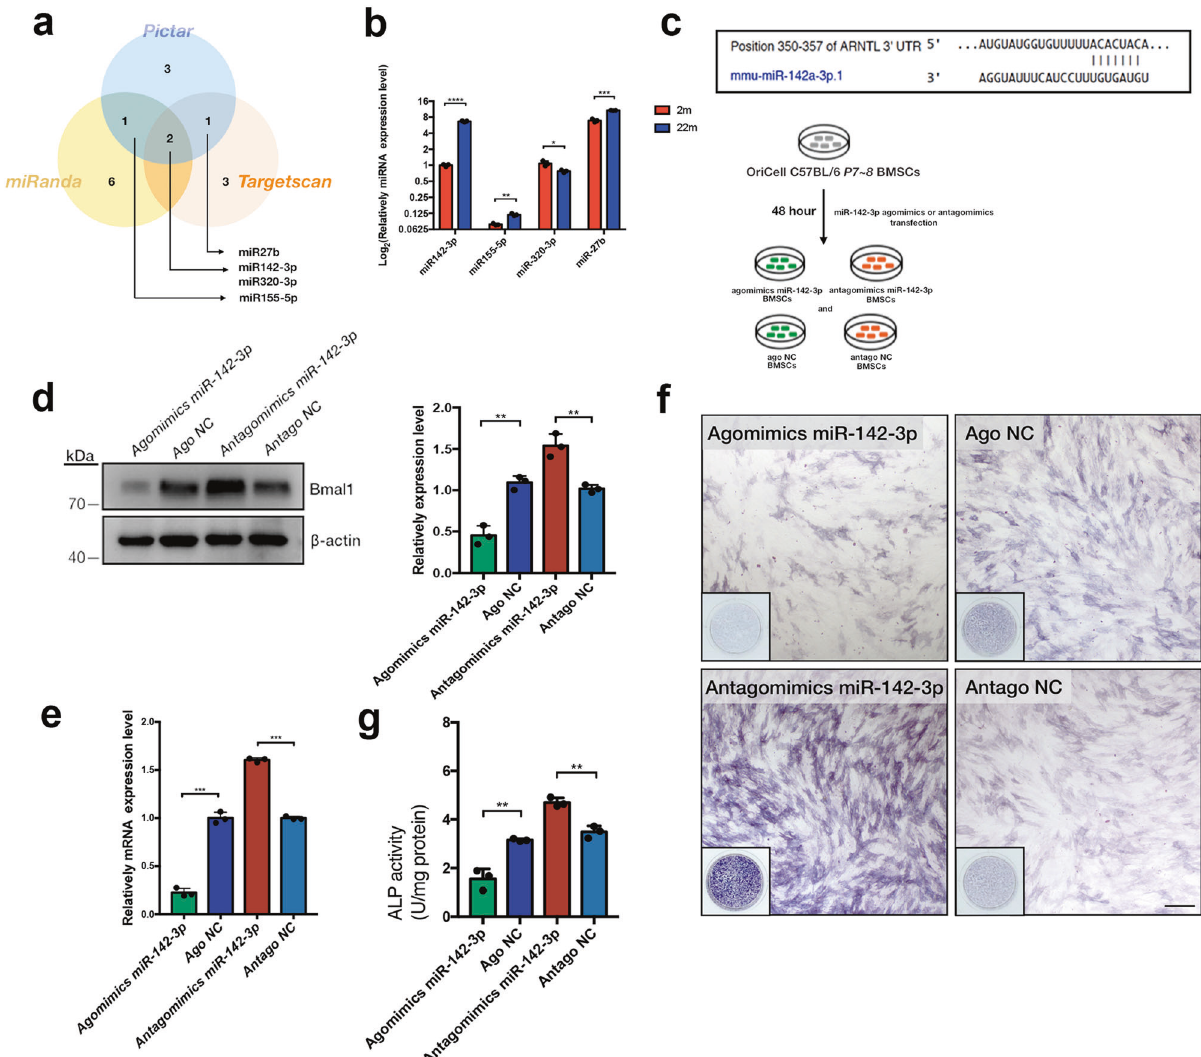
Fig. 2 Age-dependent miR-142-3p downregulates the clock gene Bmal1 and alters osteogenic capability in BMSCs. a Venn diagram showing predicted miRNAs targeting Bmal1 with three bioinformatic algorithms (TargetScan, Pictar and miRanda). b qRT-PCR analysis of the expression of predicted miRNAs (miR142-3p, miR155-5p, miR320-3p and miR-27b) in 2-month-old and 22-month-old BMSCs. c Predicted miR- 142-3p binding site on Bmal1 3 ’ UTR and work fl ow diagram of miR-142-3p agomimics and antagomimics transfection in OriCell C57/BL6 BMSCs. The cells were named Agomimics miR-142-3p, Ago NC, Antagomimics miR-142-3p and Antago NC. d Western blot and quantitative analysis of Bmal1 expression 48 h after transfection of miR-142-3p agomimics and antagomimics. e qRT-PCR analysis of mRNA expression of Bmal1 after 48 h transfection of miR-142-3p agomimics and antagomimics. f ALP staining at day 7 of osteogenic induction after transfection of miR-142-3p agomimics and antagomimics. Scale bar: 200 μ m. g Quantitative analysis of data f. Transfected group was compared with mock group. N = 3, Data are presented as mean ± SD; * p < 0.05, ** p < 0.01, *** p < 0.001 by two-tailed Student ’ s t